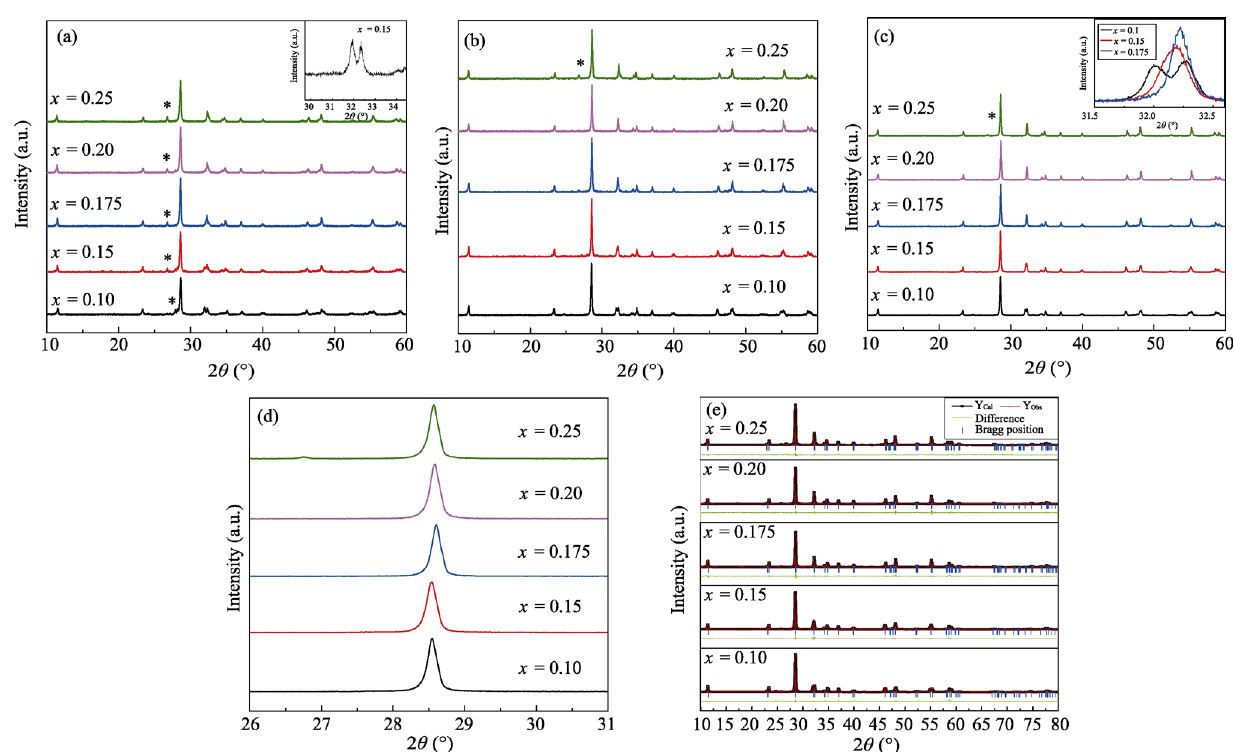
Fig. 1 XRD patterns of the Bi 2 V 1– x Al x /2 Ti x /2 O 5.5– δ (0.10 ≤ x ≤ 0.25) specimens after (a) calcination at 650 ℃ , (b) 2nd calcination at 750 ℃ , (c) sintering at 800 ℃ , (d) the maximum intensity peak at ~28.5°, and (e) fitting with Rietveld refinement sintered at 800 ℃ . Table 1 Percentage of orthorhombic and tetragonal phases with variation of dopant concentration x Orthorhombic symmetry (%) Tetragonal symmetry